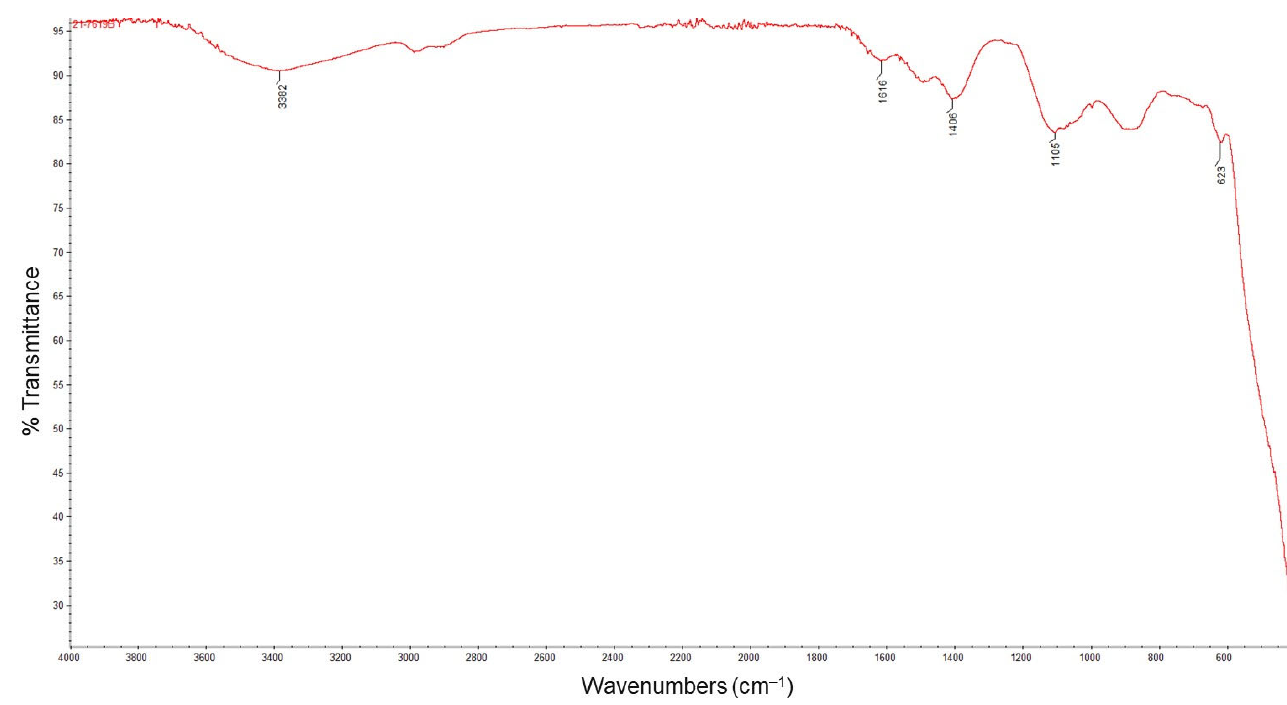
Figure 1. UV–vis spectrum of ZnO NPs synthesized with Sargassum sp.: ( a ) macroalgae Sargassum sp. after sieve analysis, ( b ) aqueous extract from Sargassum sp., ( c ) biosynthesized ZnO NPs, and ( d ) ZnO NPs after drying.